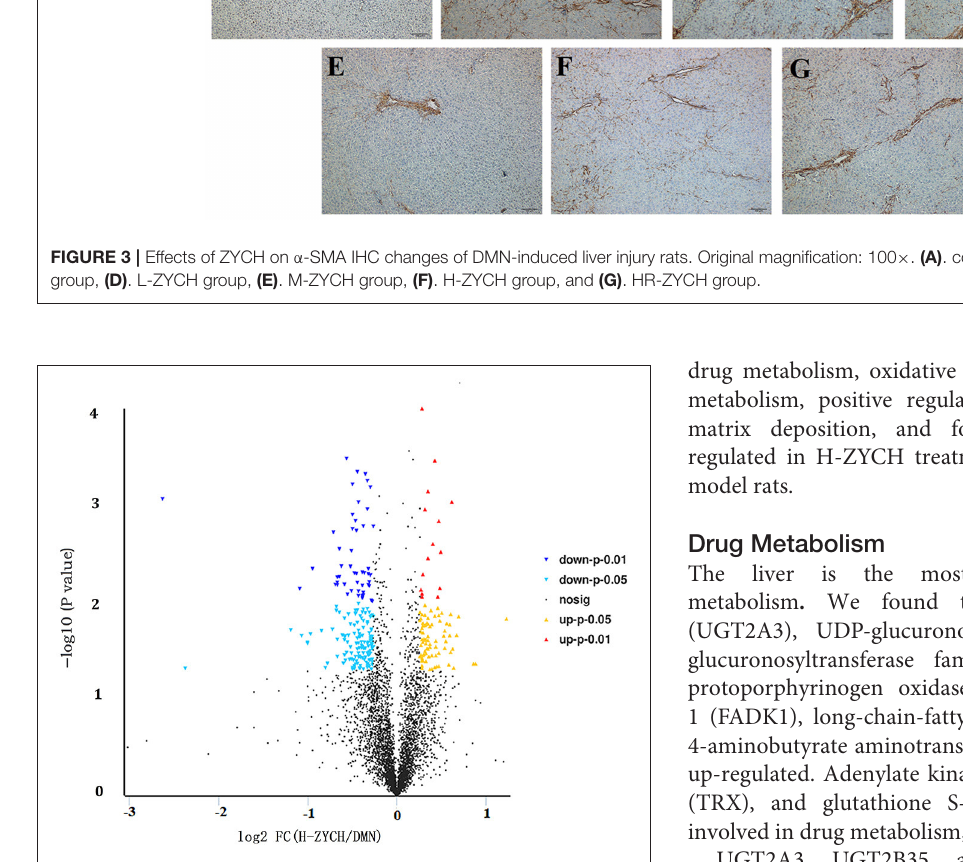
FIGURE 4 | Volcano plot analysis of differentially expressed proteins between H-ZYCH and DMN-model groups. Volcano plot of ratios and p -value represented the protein abundance changes in the comparison between H-ZYCH and DMN-model groups. Proteins with p < 0.05 and above/below 1.2-fold changes are identified as proteins with significant changes. Down-regulated with p < 0.01 (dark blue dots), down-regulated with 0.01 ≤ p < 0.05 (light blue dots), up-regulated with p < 0.01 (red dots), and up-regulated with 0.01 ≤ p < 0.05 (yellow